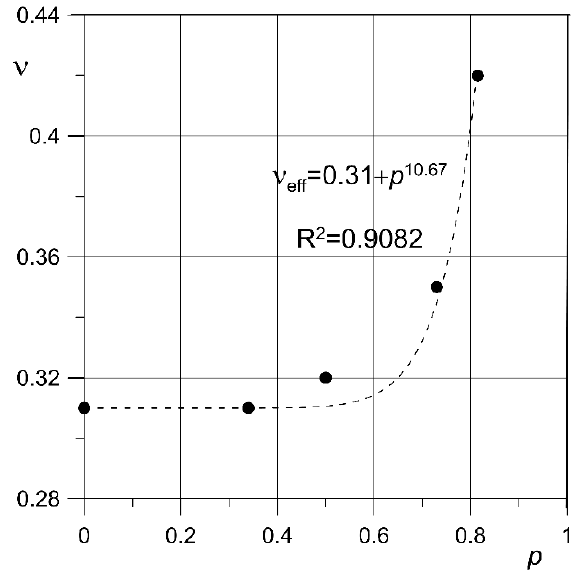
Figure 9. Effective Poisson's ratio values approximated by Equation (6). Figure 9. E ff ective Poisson’s ratio values approximated by Equation